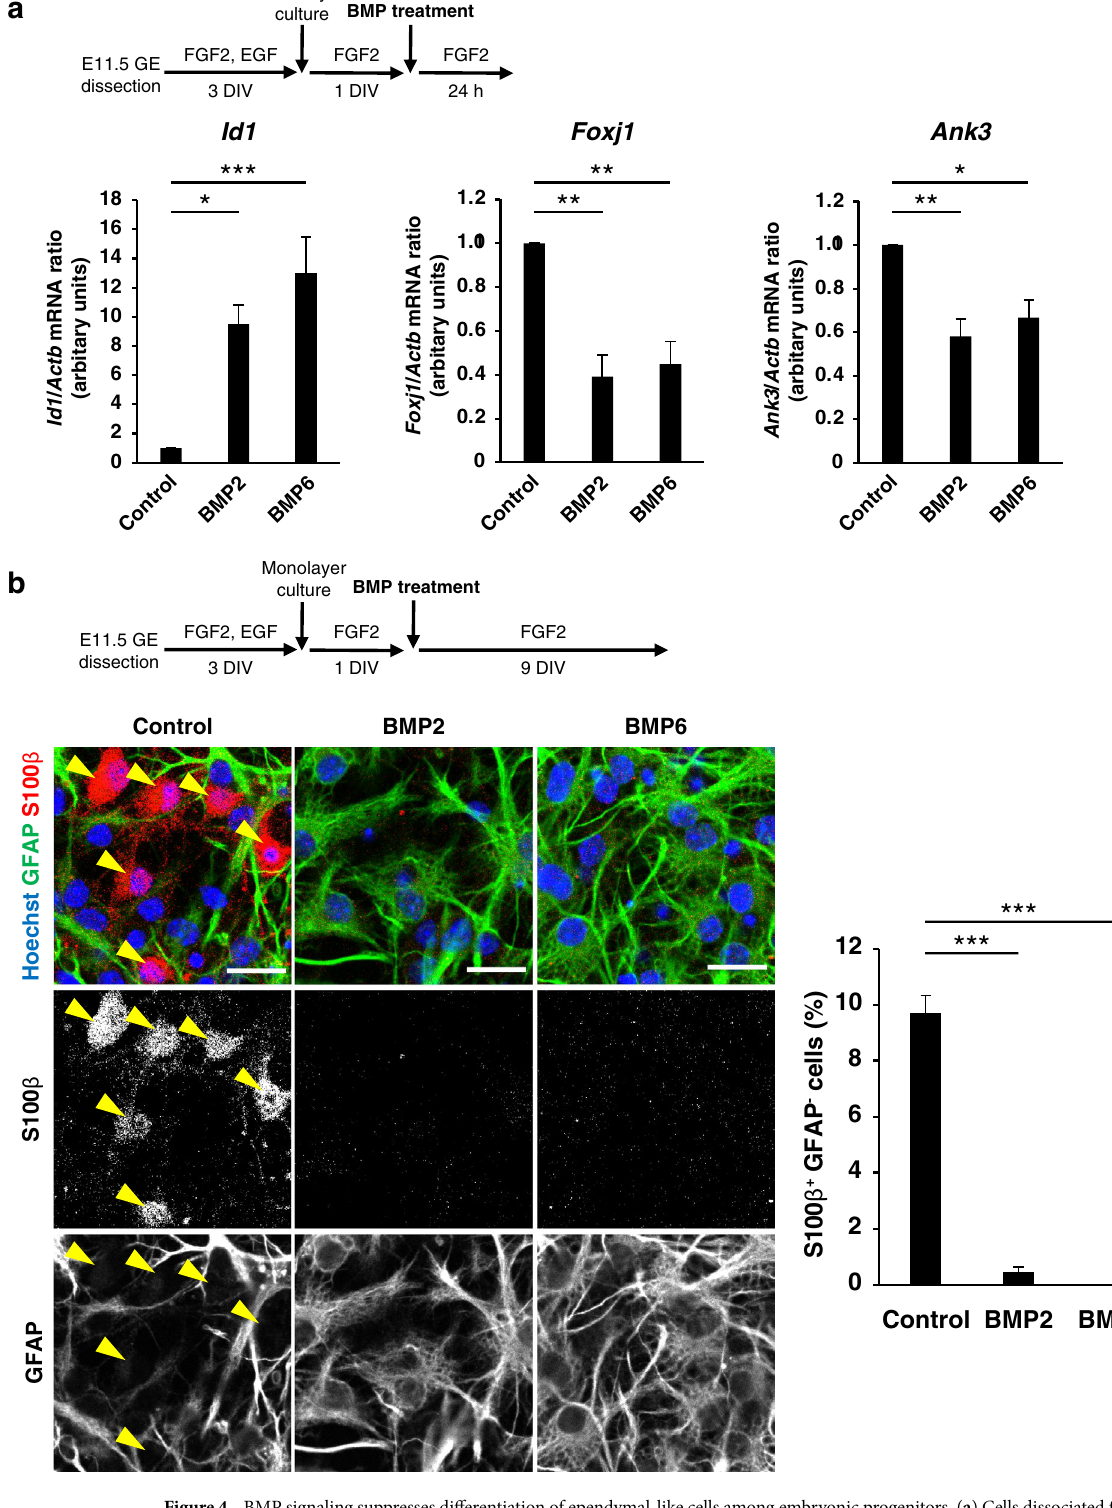
Figure 4. BMP signaling suppresses differentiation of ependymal-like cells among embryonic progenitors. ( a ) Cells dissociated from the GE of E11.5 embryos were cultured for 3 days in suspension, and the resulting neurospheres were dissociated and cultured as monolayers for 1 day before exposure to BMP2 (50 ng/ml) or BMP6 (50 ng/ml) for 24 h. The amounts of Id1 , Foxj1 and Ank3 mRNAs in the cells were then determined by quantitative RT-PCR analysis. Data are means ± SEM (n = 3 independent experiments). * p < 0.05; ** p < 0.01; *** p < 0.001 (Tukey’s test). ( b ) Cultures as in ( a ) exposed to BMP2 or BMP6 for 9 days (with replenishment of the medium every 2 days) were subjected to immunocytofluorescence staining with antibodies to S100β and to GFAP. Nuclei were counterstained with Hoechst 33342. Arrowheads indicate S100β + GFAP – ependymal-like cells. Scale bars, 20 μm. The percentage of S100β + GFAP – cells was determined. Three microscope fields were counted per sample. Total of 200–300 cells were counted per sample. Data are means ± SEM (n = 3 independent experiments). *** p < 0.001 (Tukey’s